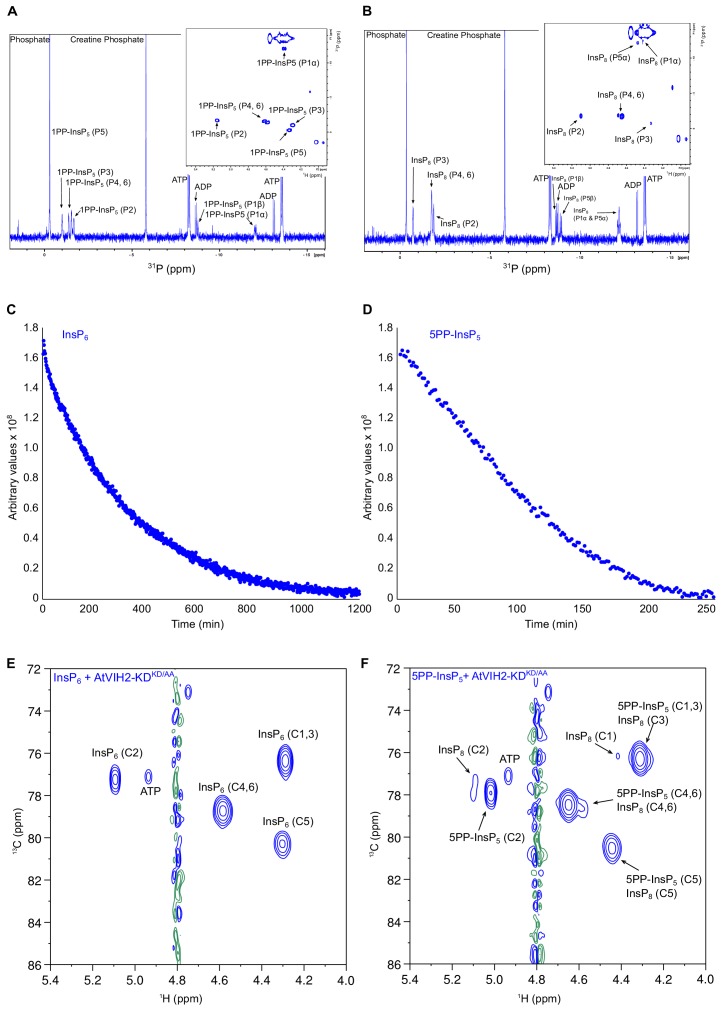
1D 31P and 2D 1H-31P-HMBC spectra of the products produced by AtVIH2-KD, and 2D 1H-13C-HMBC spectra of the products produced by plant AtVIH2-KDKD/AA.(A,B) 1D 31P spectra of the products produced by the plant AtVIH2-KD in the presence of InsP6 (A) and 5PP-InsP5 (B). Inset panels shows the 2D 1H-31P-HMBC spectra. 1,5(PP)-InsP4 refers to InsP8. (C, D) Decay of the InsP6 (C) or 5-PP-InsP5 (D) substrate during the NMR-time course experiment. (E, F) 2D 1H-13C-HMBC spectra of the products produced by plant AtVIH2-KDKD/AA (blue trace) in the presence of InsP6 (E) or 5PP-InsP5 (F).